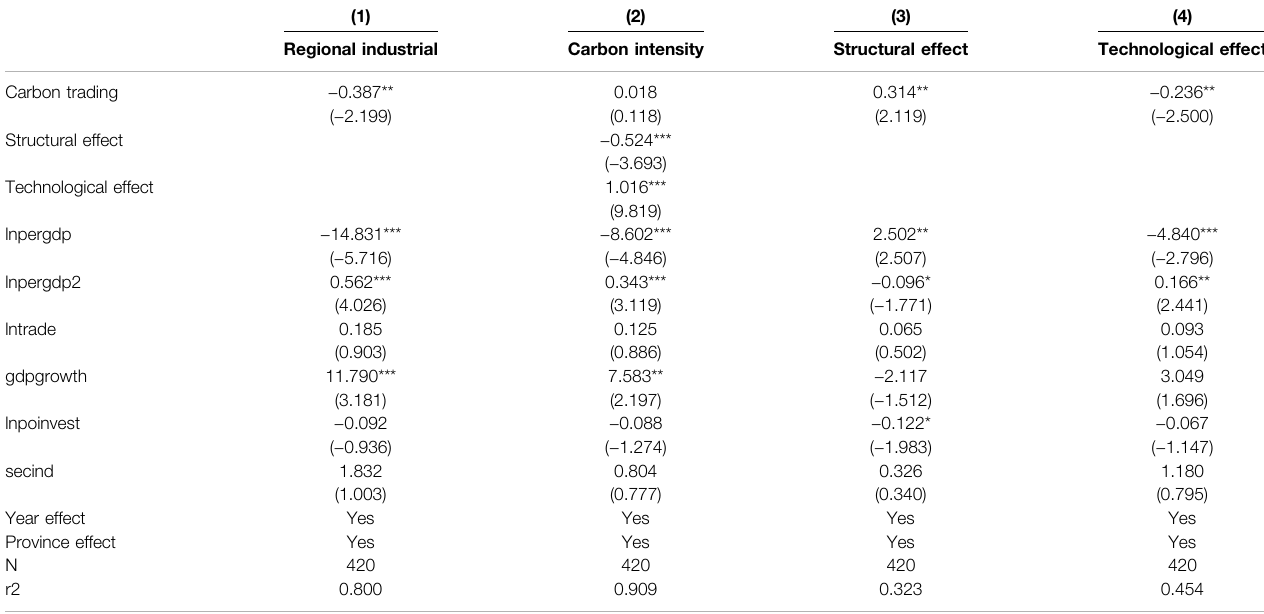
TABLE 5 | Mechanism veri fi cation of the impact of carbon trading on regional industrial carbon